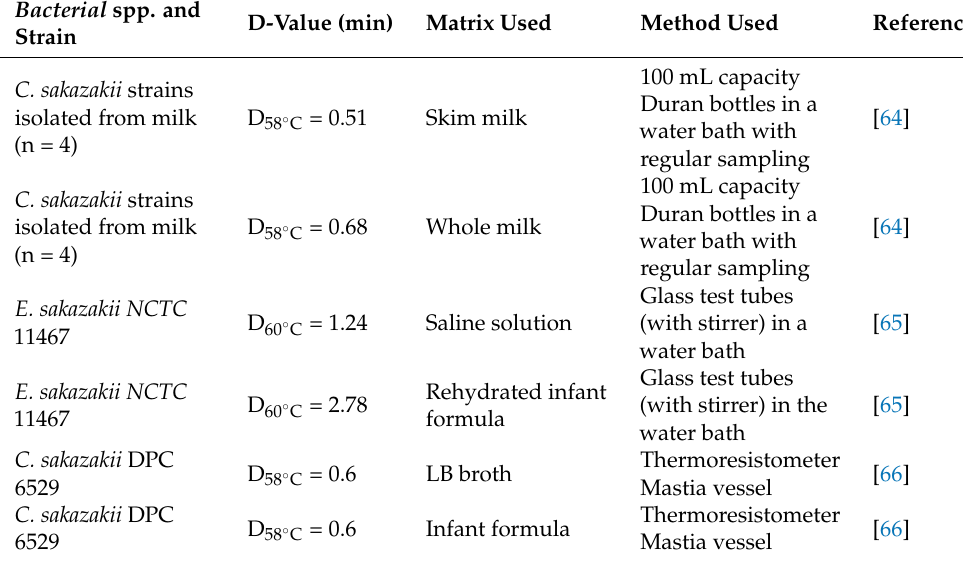
Matrix Used Method